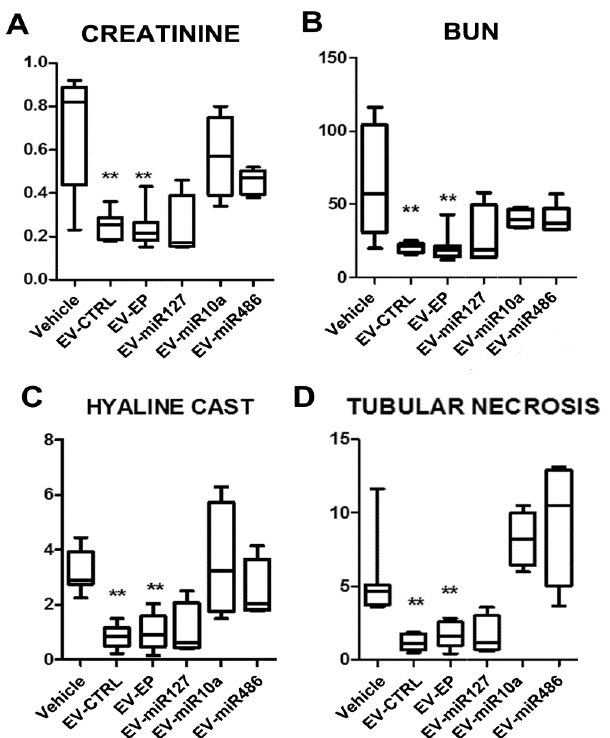
Figure 5. E ff ect of EVs derived from naïve or electroporated MSC in AKI mice: Functional and morphological evaluation. ( A ) Creatinine and ( B ) blood urea nitrogen (BUN) values in AKI mice injected with vehicle alone (Vehicle) or with 165 × 10 6 EVs derived from naïve MSCs (EV-CTRL) or from electroporated MSCs (EV-EP) transfected with di ff erent miRNA mimics (EV-miR127, EV-miR10a, EV-miR486). EVs were injected at day 3 and mice were sacrificed at day 5 after glycerol administration. Results are expressed as mean ± SD; ANOVA with Dunnett’s multiple comparison test was performed. ** p < 0.01 EV-CTRL and EV-EP vs. Vehicle. Morphometric evaluation of ( C ) hyaline casts and ( D ) tubular necrosis in AKI mice treated with vehicle alone (Vehicle) or injected with 165 × 10 6 EVs derived from naïve MSCs (EV-CTRL) or from electroporated MSCs (EV-EP) transfected with di ff